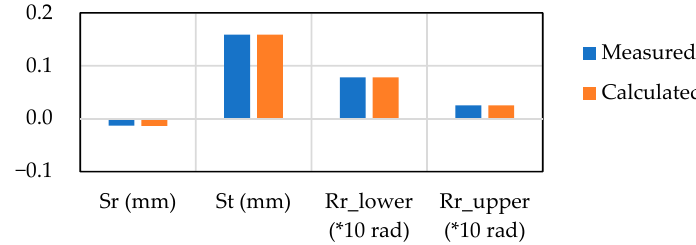
Figure 11. Fitting of the axisymmetric inherent deformation modes.